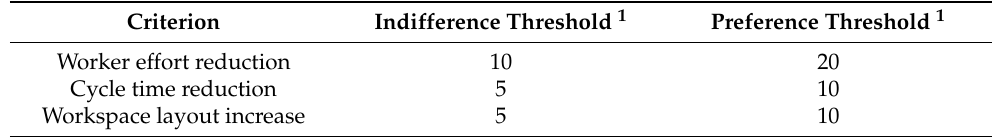
Table 1. Threshold values for observed Figure 7. The rank of alternatives for each observed scenario.